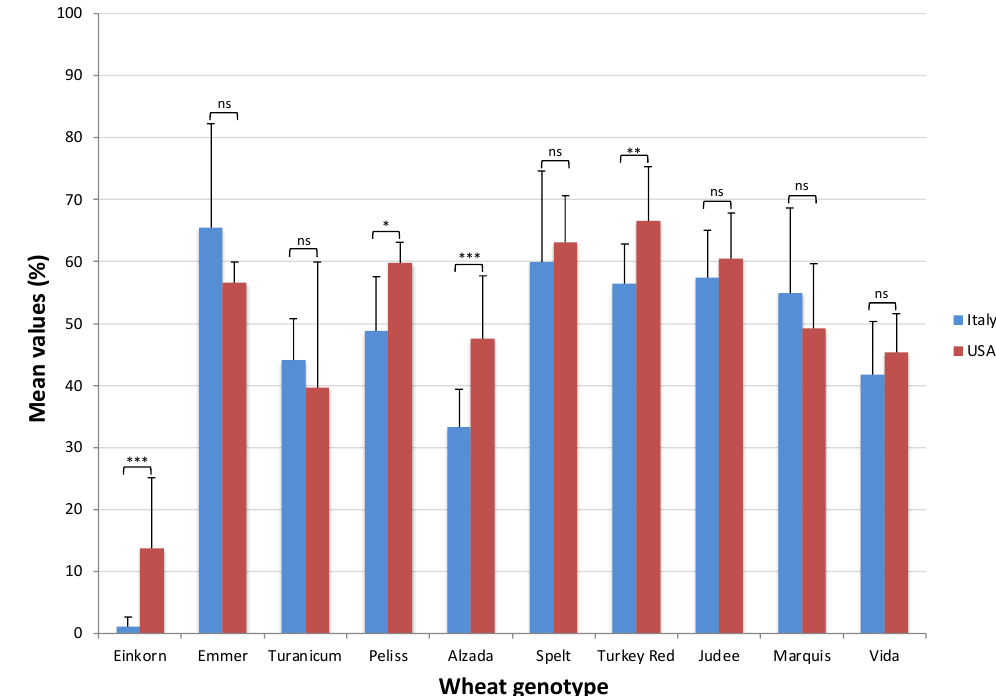
Figure 3. Differences between the mean values of alpha-amylase inhibitory activity in the USA and in Italy for each wheat genotype. Significance level: * p < 0.05; ** p < 0.01; *** p < 0.001. ns, not signifi- cant.